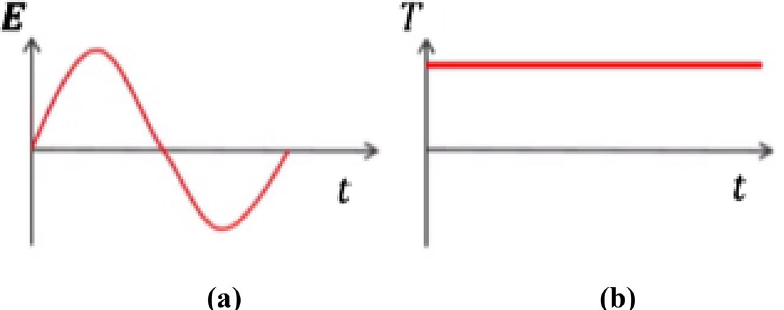
Figure 2. ( a ) The power dissipation as a time dependent for one cycle, ( b ) the steady state temperature by thermal heating as a function of